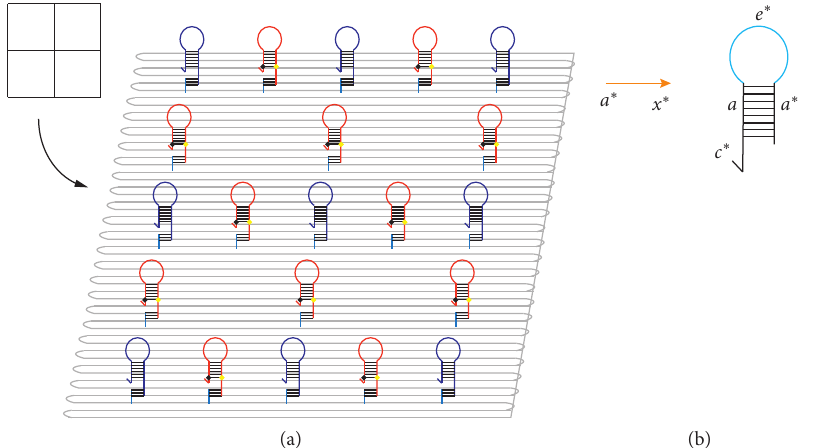
Figure 2: (a) Circuit diagram of origami base and hairpin structure; (b) cipher chain, consisting of starting chain (left) and intermediate chain